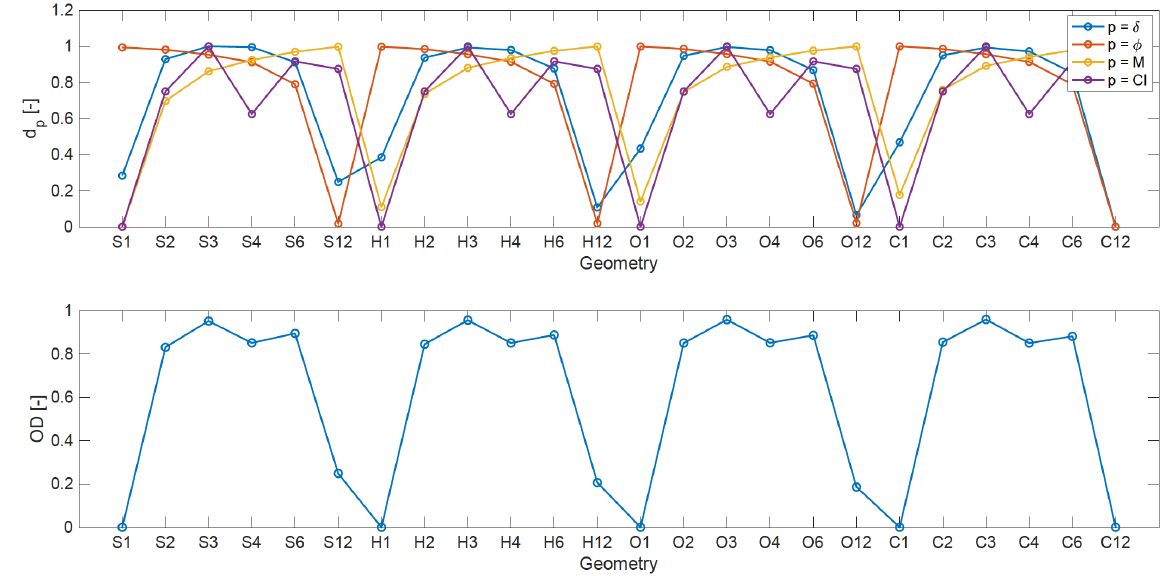
Figure 2: (a) Individual desirability values for the four response variables ( r p = 1 ) and (b) OD values